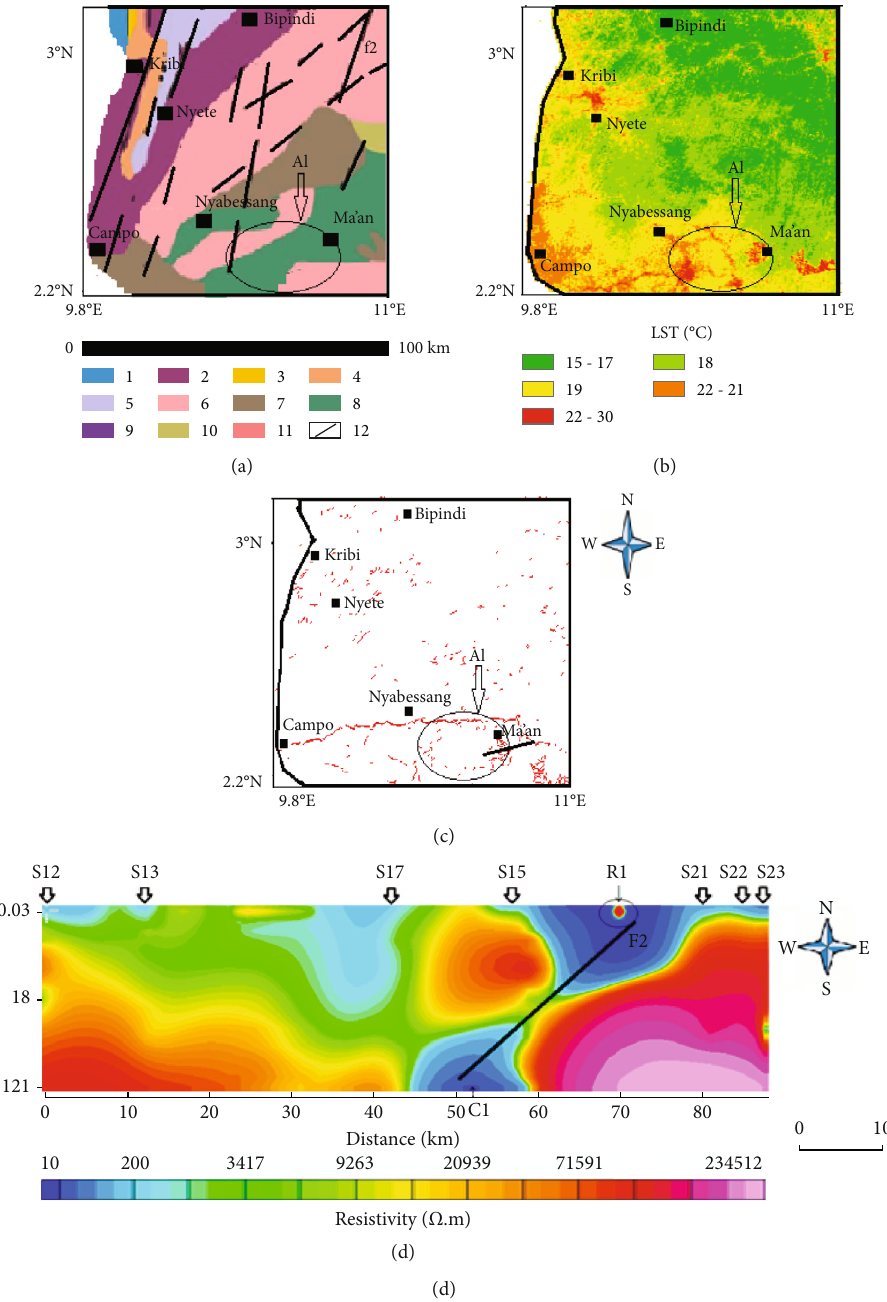
Figure 16: Correlative map. (a) Geological maps. (b) LST. (c) Lineaments. (d) Resistivity